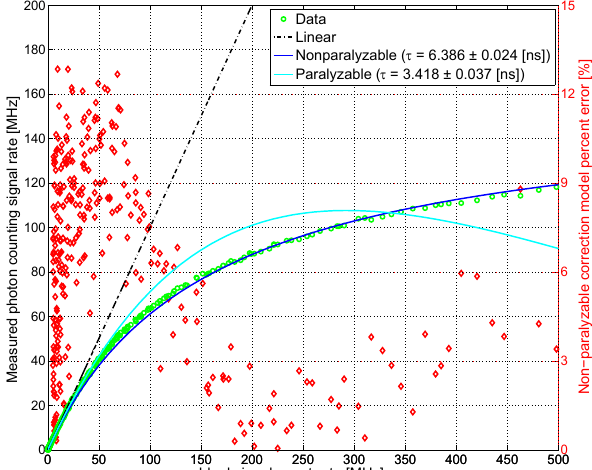
Figure B1. Saturation analysis of the CAPABL photon counting channel using the theory developed by Donovan et al. (1993), Whiteman (2003), and Liu et al. (2009). The ideal signal count rate is found by normalizing the analog detection channel to the photon counting channel in a region where both are acting linearly which is about 1MHz count rate. The measured count rate is then taken directly from photon counting measurements. The paralyzable and non-paralyzable models are then fit using a Levenberg–Marquardt weighted nonlinear least squares fitting algorithm of the observed calibration data. The 1 σ confidence bound is given for each dead time fit parameter. Finally, the percent error of the correction model is given relative to the ideal count rate on the right ordinate as dia-